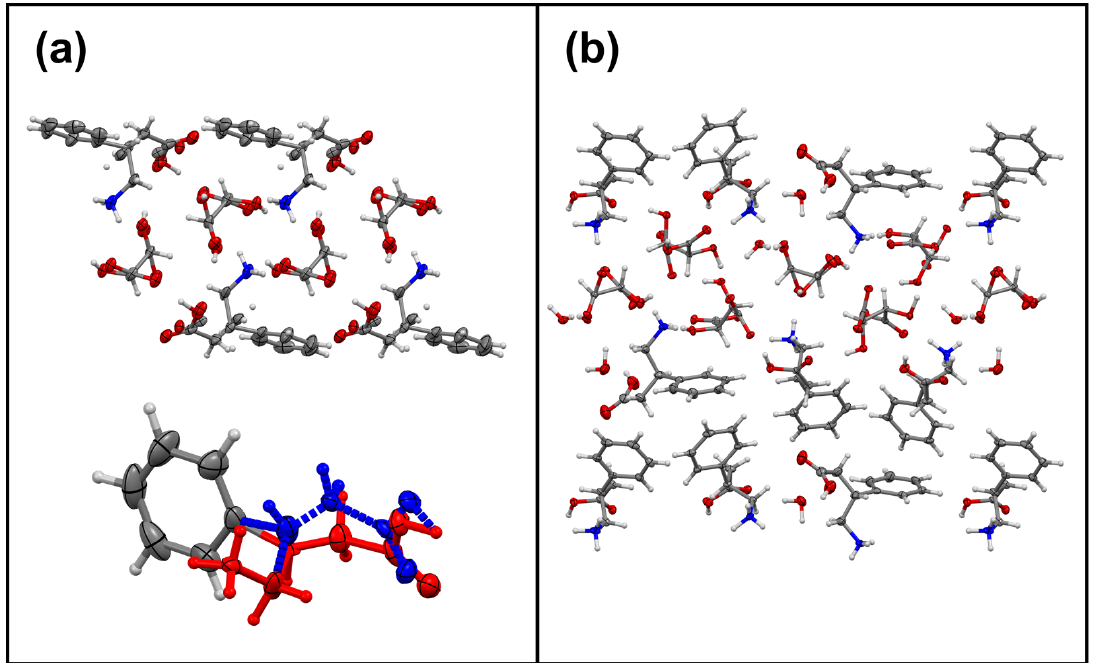
Figure 8 . Structure comparison of ( a ) Phenibut:DL − tartaric acid (view from a-axis) with a highlighted disorder in the GABA subunit and ( b ) Phenibut:L − tartaric acid • H 2 O (view from a-axis). Phenibut occurs in two half-occupied GABA-subunit confirmations in a), as shown through additional atom positions along the chain, which is highlighted between the red and blue colored atoms and bonds on the Phenibut molecule. Carbon atoms are depicted in grey, hydrogen atoms are depicted in white, oxygen atoms are depicted in red and nitrogen atoms are depicted in blue.